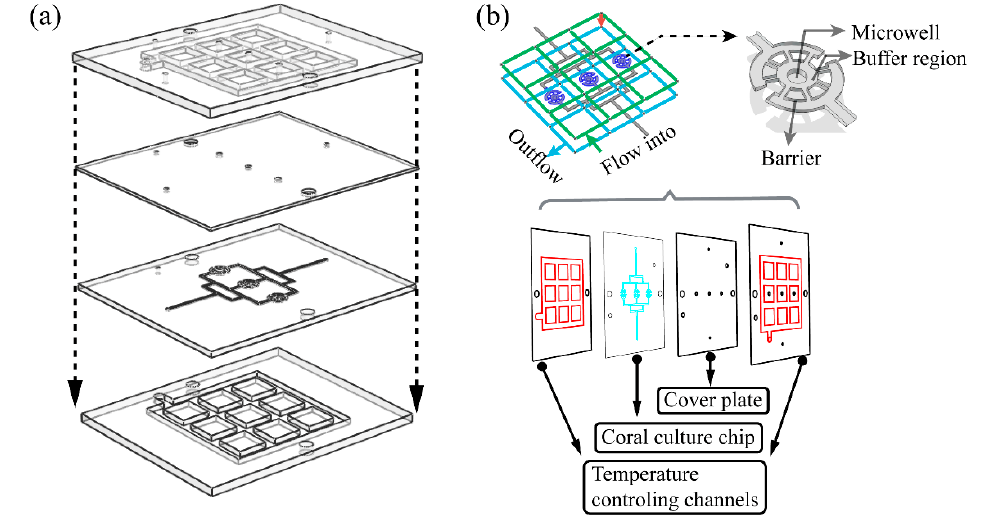
Figure 1. Schematics of the dynamic culture microdevice. ( a ) 3D assembly of different components. ( b ) Zoom-in images for the culture chip and temperature controlling module.